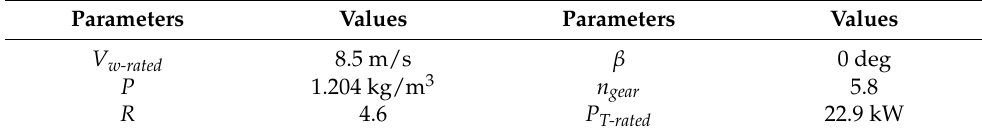
Table 6. Parameters of the wind turbine. Parameters Values Parameters